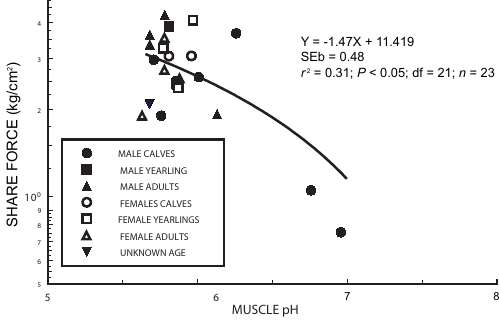
Fig. 4. Relationship between shear force (kg/cm 2 ) applied to loin steak and muscle pH pf reindeer loin steaks from Nunivak Island, Alaska, January,